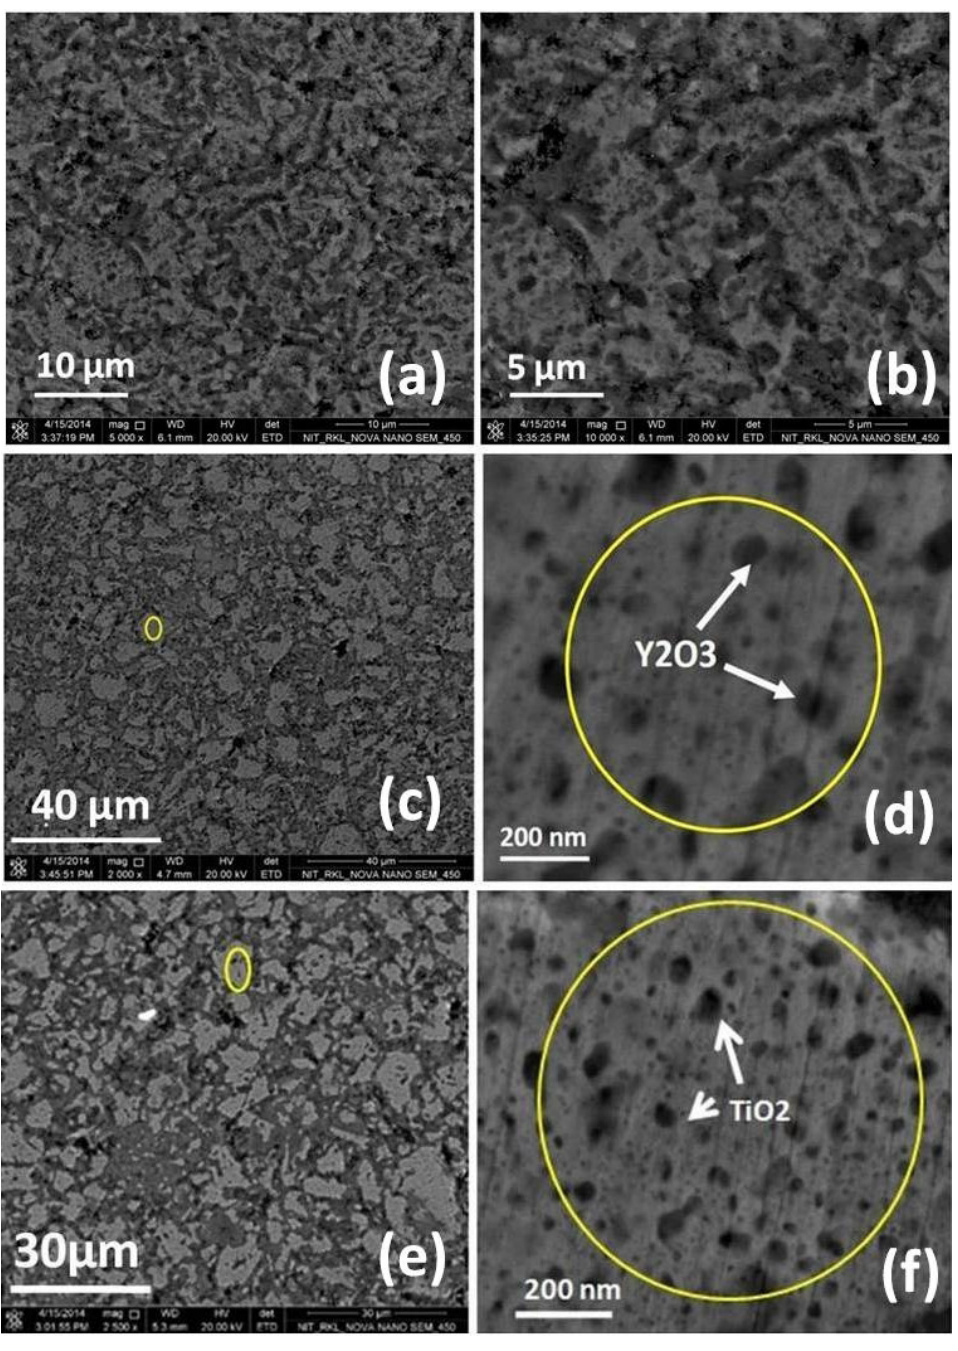
Fig. 5 FE-SEM micrographs of alloys A, B and C at different magnifications: Alloy A (a), (b); Alloy B (c), (d); alloy C (e),(f).